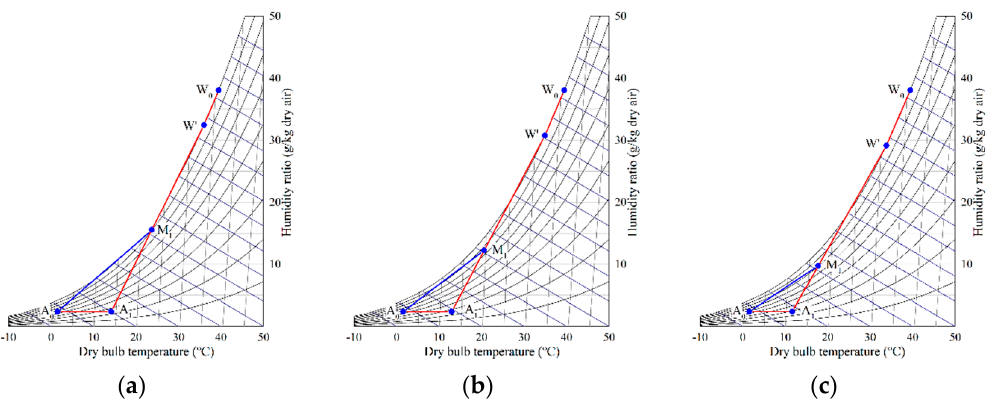
Figure 8. Thermodynamic process with different N values. ( a ) N = 4, ( b ) N = 6, and ( c ) N = 8.